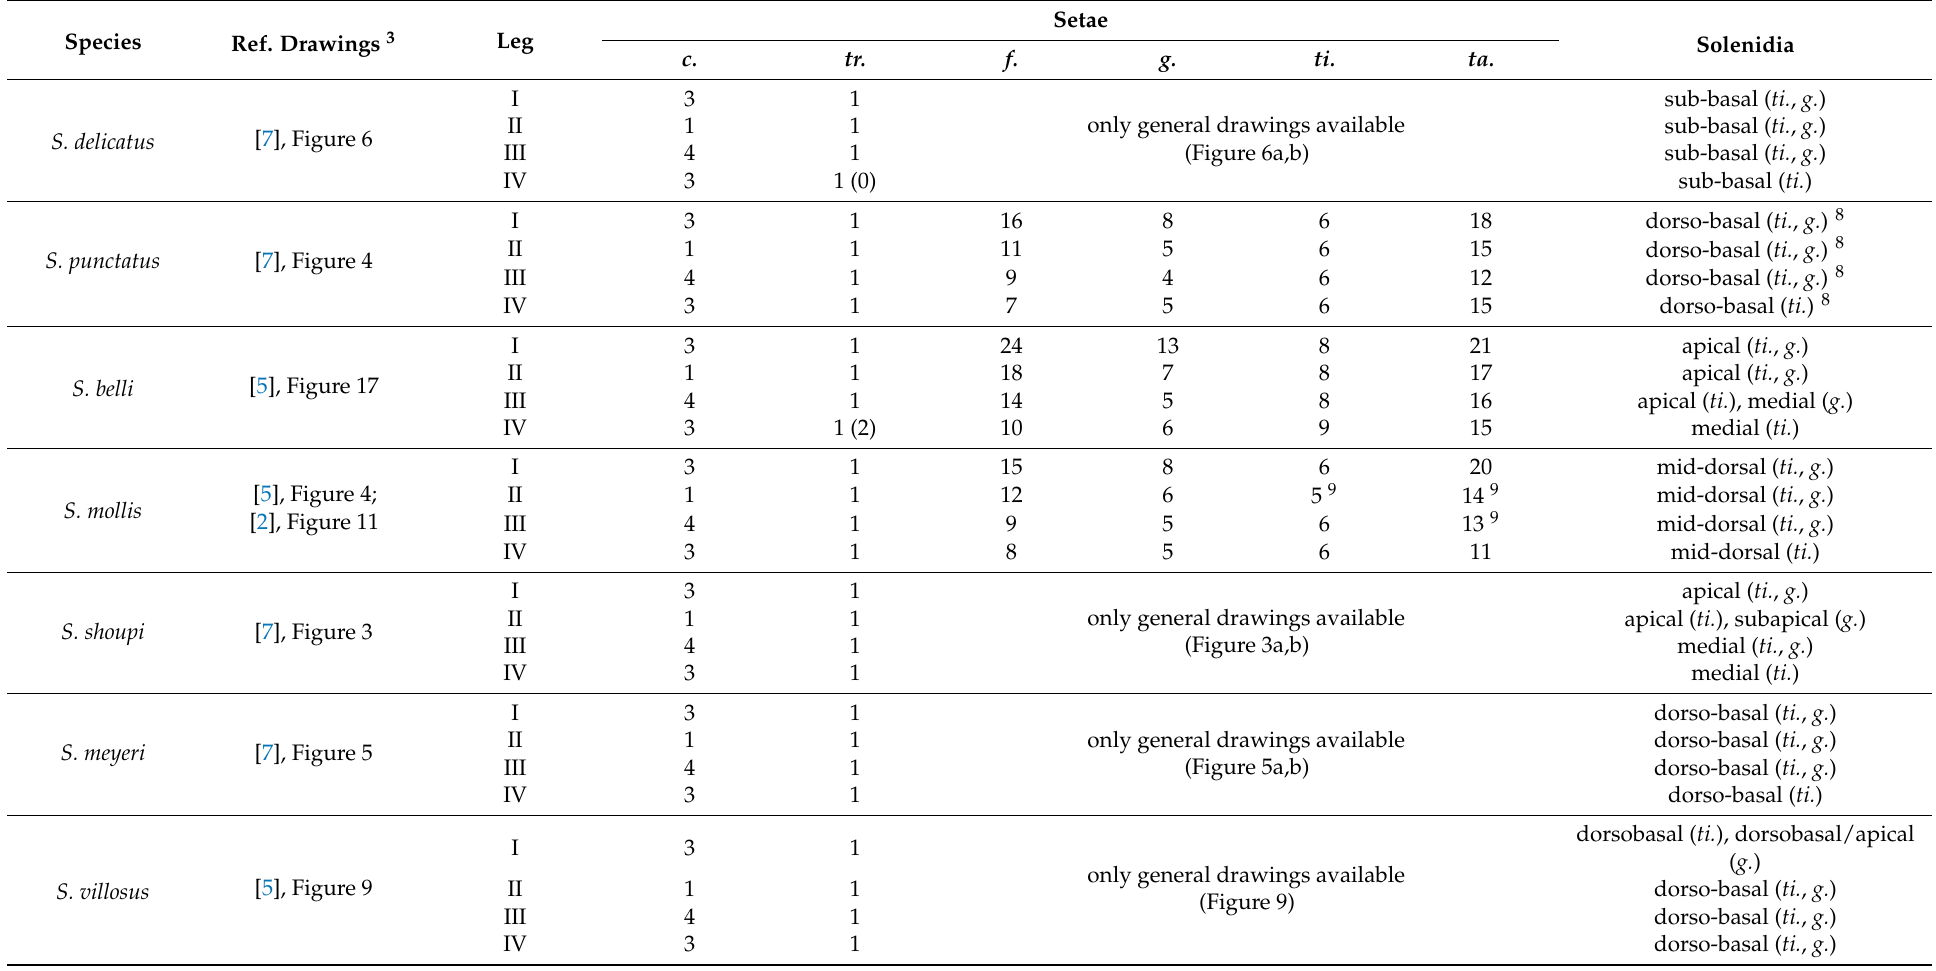
Table A6. Synoptic table of the leg chaetotaxy of the Antarctic and sub-Antarctic Stereotydeus species. c. coxa, tr. trochanter, f. femur, g. genu, ti. tibia and ta. tarsus. in blu: n. of coxal setae extrapolated from the drawings (following Pittard [2]); in green: n. of trochanter setae extrapolated from drawings; in red: possible mistakes in original articles.